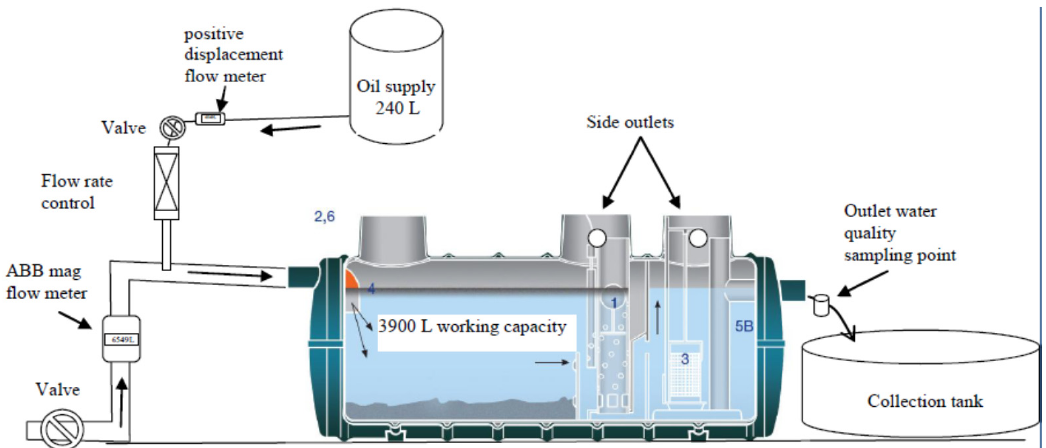
Figure 2. Typical schematic of the Puraceptor™ Test Rig—side view [18]. Table 1. HR Wallingford Water Quality Results.